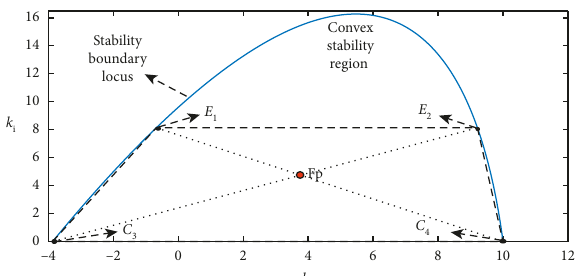
Figure 6: Convex stability region and Fermat point of PI controller in example B.